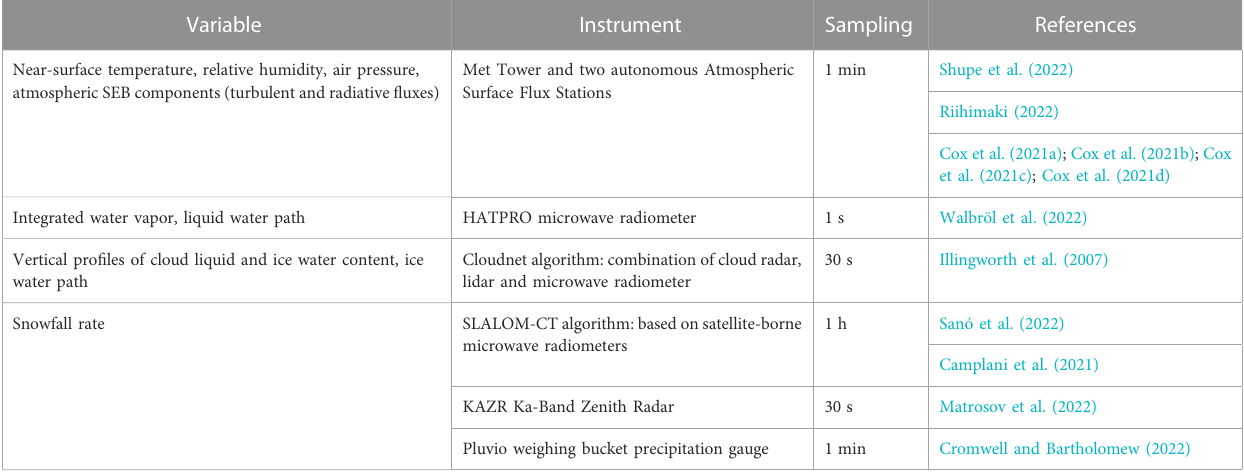
TABLE 1 Overview of MOSAiC measurements used in this study. For all analyses, the original data was averaged to hourly